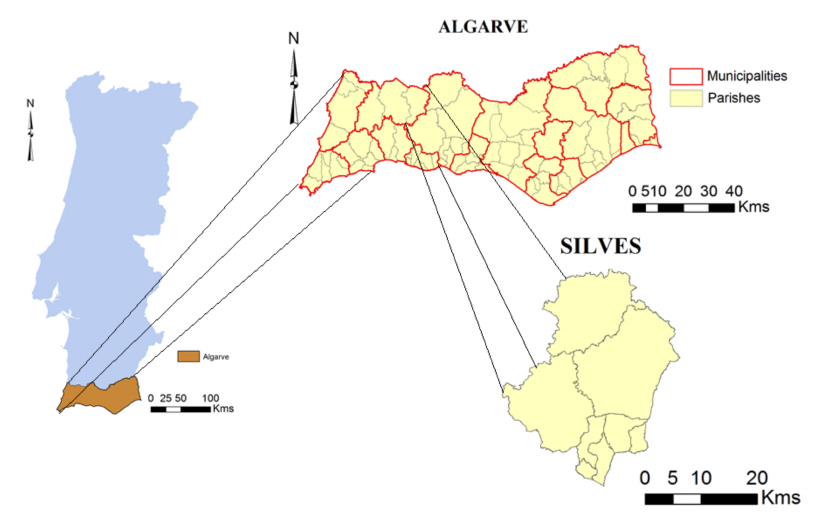
Figure 2. The study